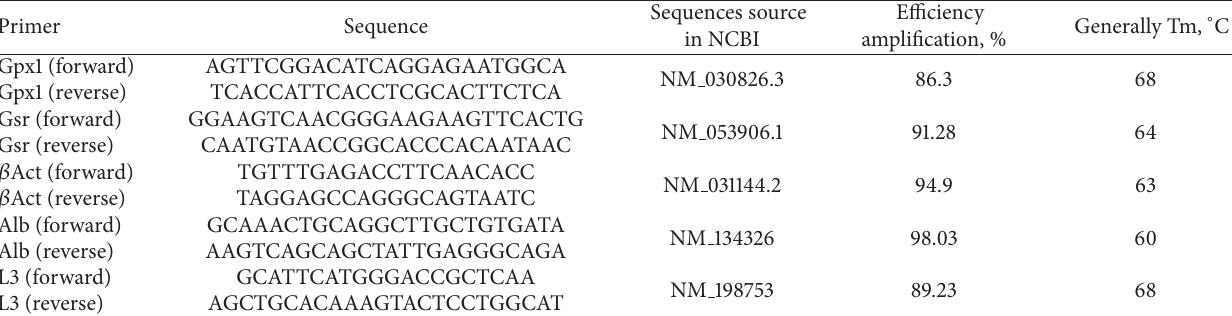
Table 1: Primers of genes Gpx1, Gsr, 𝛽 Act, Alb, and L3 used for real-time